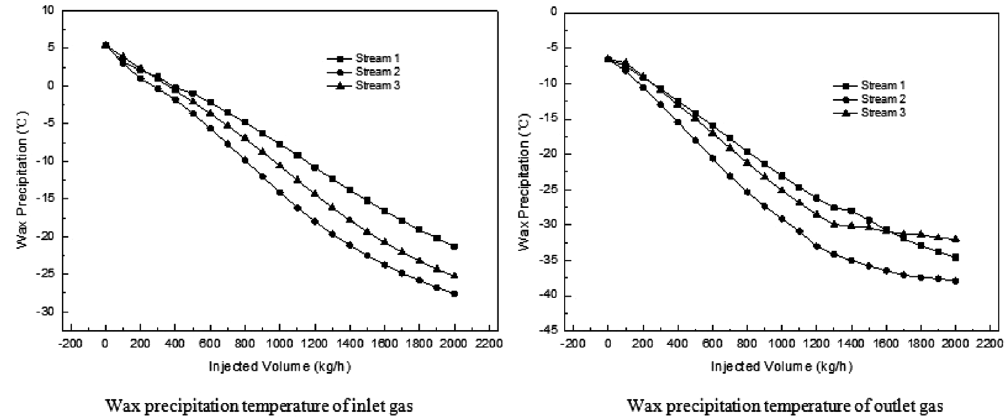
Fig. 7. The variation of wax precipitation temperature of the inlet/outlet gas of high-pressure separator with the injected volume.